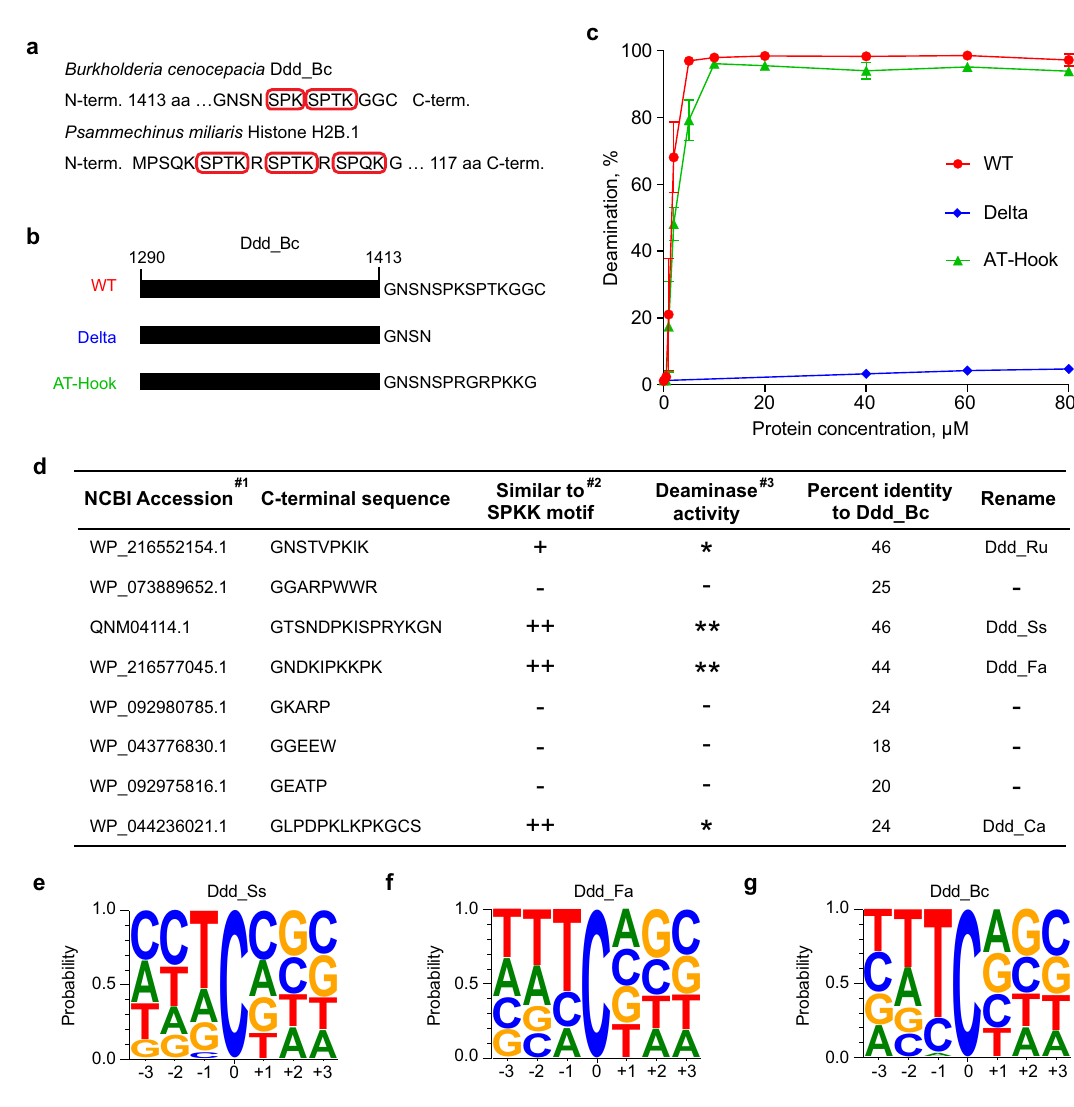
Fig. 1 | SPKK-related motifs help identify Ddd_Bc homologs with dsDNA dea- minase activity. a The red boxes mark the SPKK-related motif sequences in Bur- kholderia cenocepacia Ddd_Bc and Psammechinus miliaris Histone H2B.1. b The schematic of constructs for wild type Ddd_Bc (WT), Ddd_Bcwith two SPKK-related motifs removed (Delta), and Delta rescued with AT-hook sequence (AT-Hook). c Quanti fi cation of the relative amounts of deamination product versus protein concentration from different protein constructs as shown in b . Associate gels are shown in Supplementary Fig. 1a. Shown are mean±SD; n =3 independent